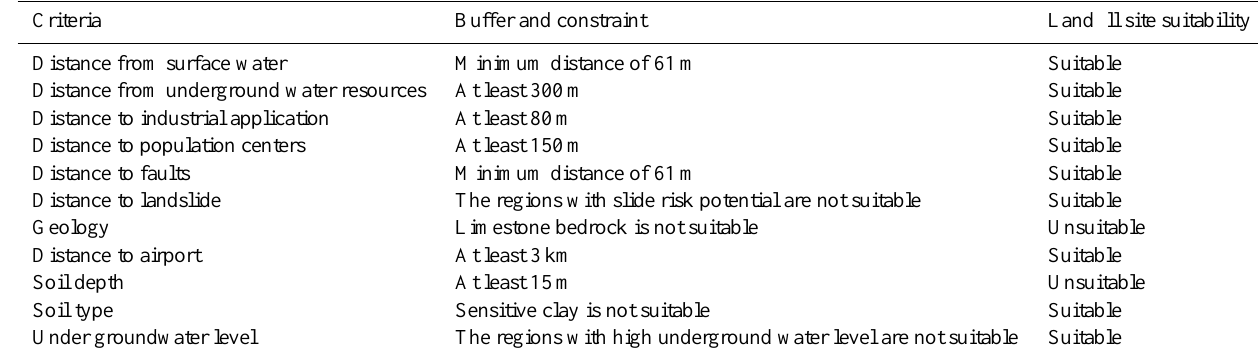
Table 4. The suitability of the Tonekabon landfill site based on the regional screening criteria. Criteria Buffer and